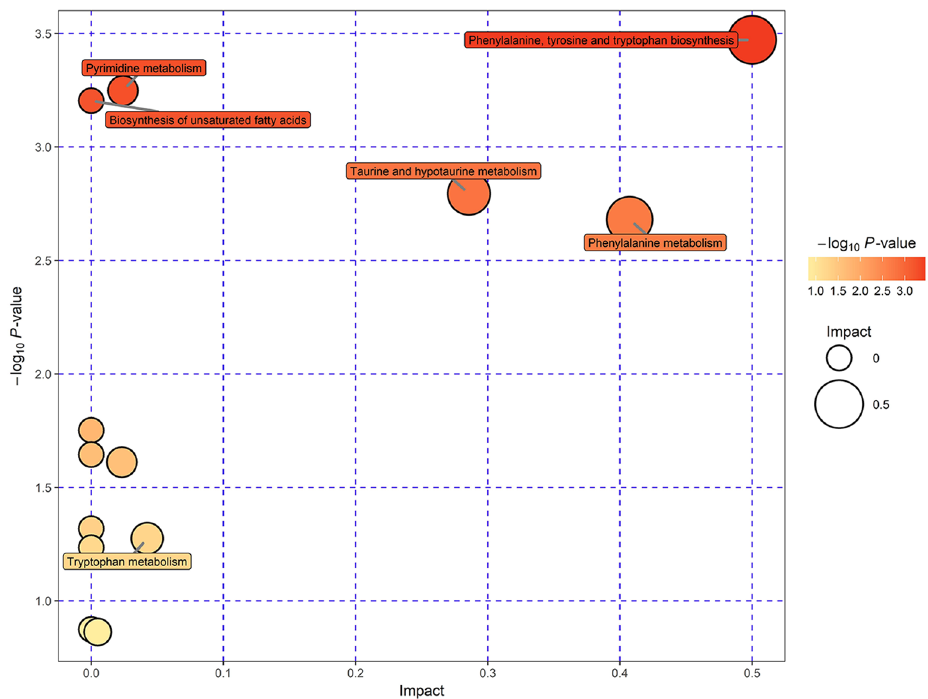
Figure 4. The pathway analysis of metabolites in the control and IBS groups (bubble diagram). Each bubble represents a metabolic pathway. The abscissa and bubble size indicate the size of the influence factor of the pathway in the topological analysis. The larger the size, the more obvious the influence became. The ordinate of the bubble and bubble color indicate the enrichment extent (negative common logarithm, i.e. − log10 P-value). The deeper the bubble color, the more significant the enrichment of metabolites